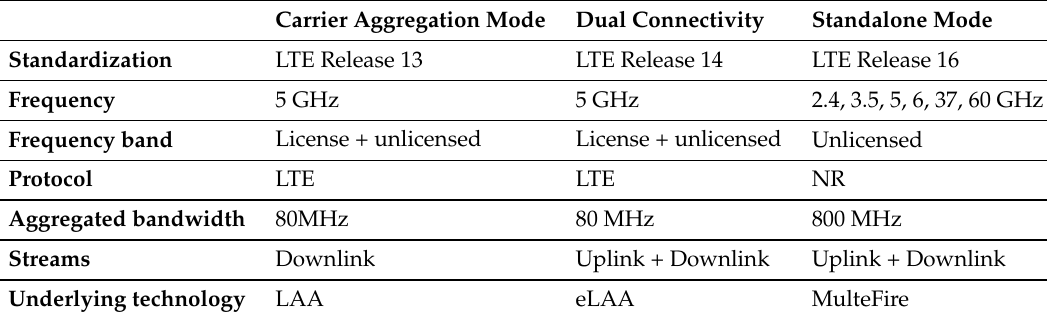
Table 3. A taxonomy of the deployment modes of